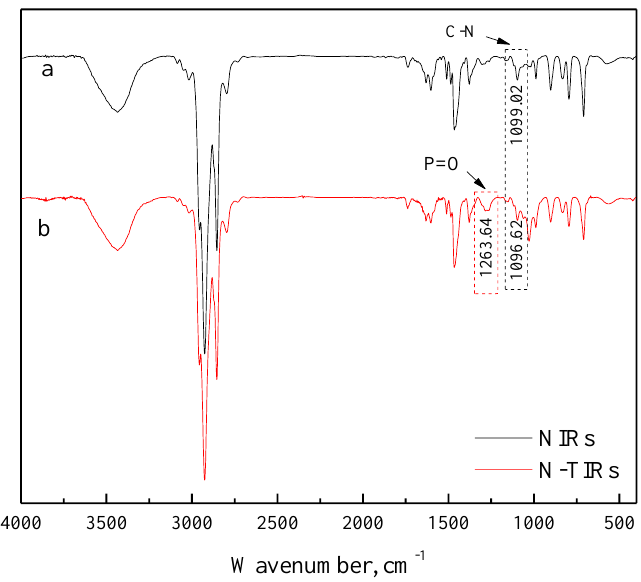
Figure 4. FTIR spectra of N235-impregnated resins (NIRs) ( a ) and N-TIRs ( b ).